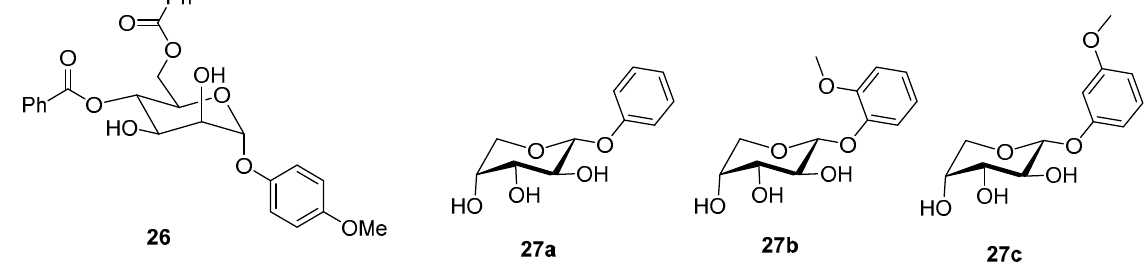
Figure 19. Structures of D-mannose derivative 26 and several arabinose derivatives 27 [61,62].